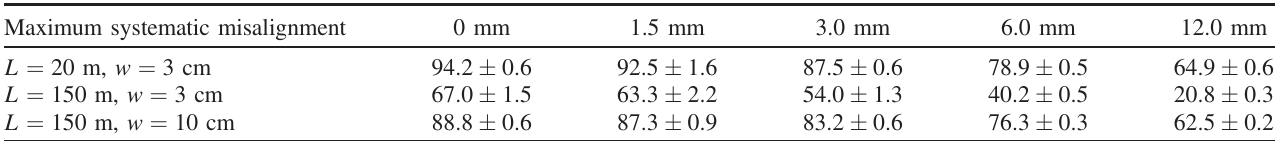
TABLE II. Mean relative transmission %, with systematic and random misalignment, averaged over five random misalignments, for different guide lengths L and widths w .